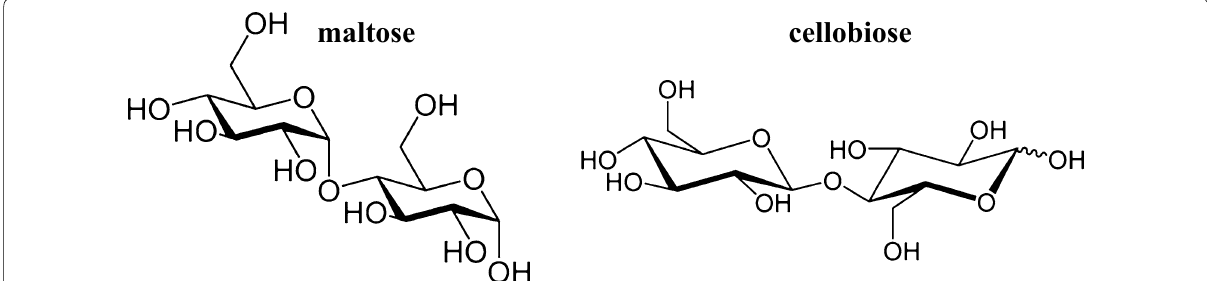
Fig. 1 Structure of two representative sugar dimers, maltose and cellobiose. Malto-sugar oligomers have an alpha orientation of the 1–4 bond and cello-sugar oligomers have a beta orientation of the 1–4